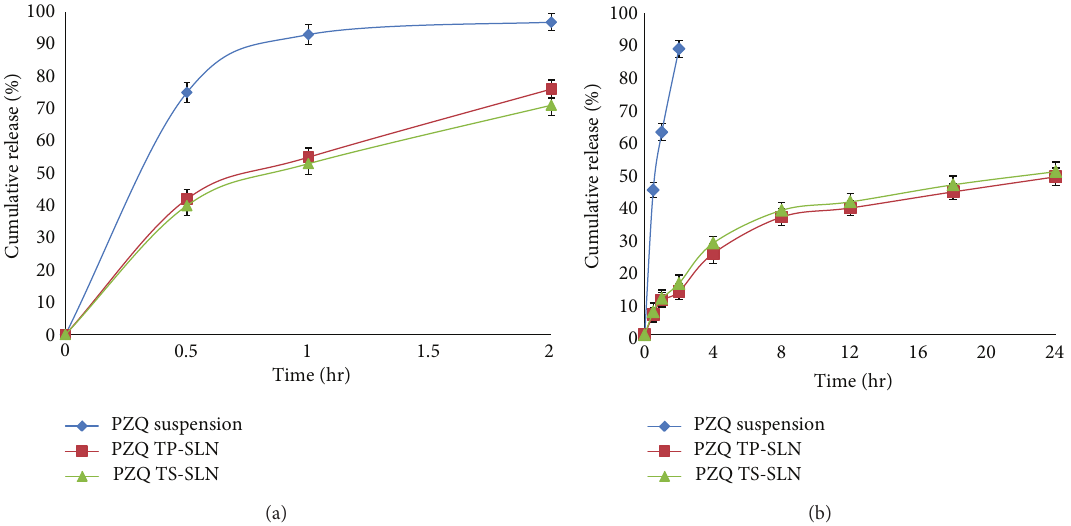
Figure 4: In vitro release profiles of PZQ-loaded SLN in (a) 0.1N HCl (pH 1.2) and (b) phosphate buffer (pH 6.8). Table 4: Pharmacokinetic parameters for praziquantel in rats after oral administration of PZQ-SLNs and PZQ suspension at an equivalent praziquantel dose of 50 mg/kg (values are means ± SD, 𝑛 = 6